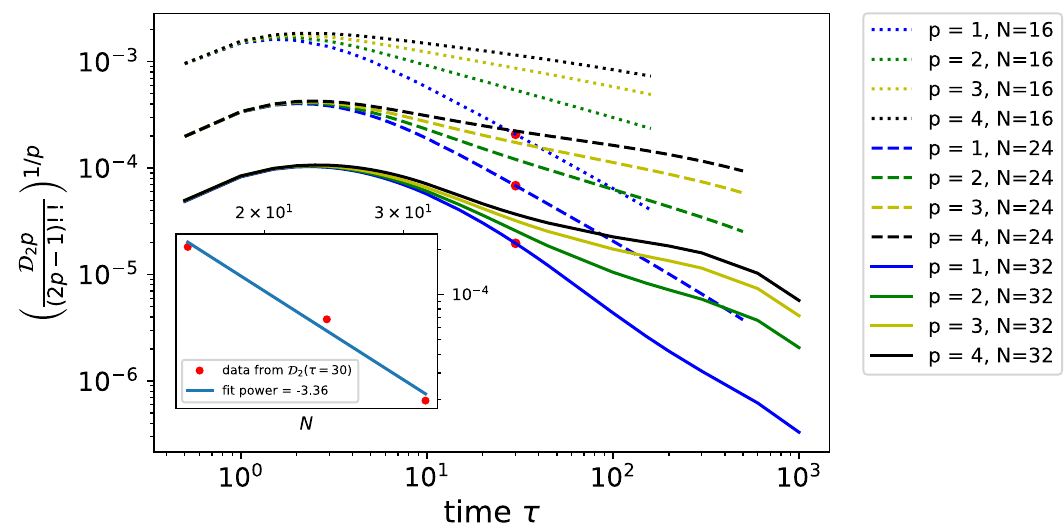
Figure 4 . Log-Log plot of versus τ for N = 16 (dots), 24 (dashed) and 32 (solid), averaged over D 2 p 50000, 5000 and 30 realizations respectively. Diminishing of the magnitude of correlation functions with N without the change of its time dependence confirms predictions of fluctuation expansion around the replica diagonal saddle point. Inset: Fit of the amplitude of the correlation function at τ = 30 for different N . The best fit is achieved for the power 3 . 36, the fluctuation expansion − predicts the power −